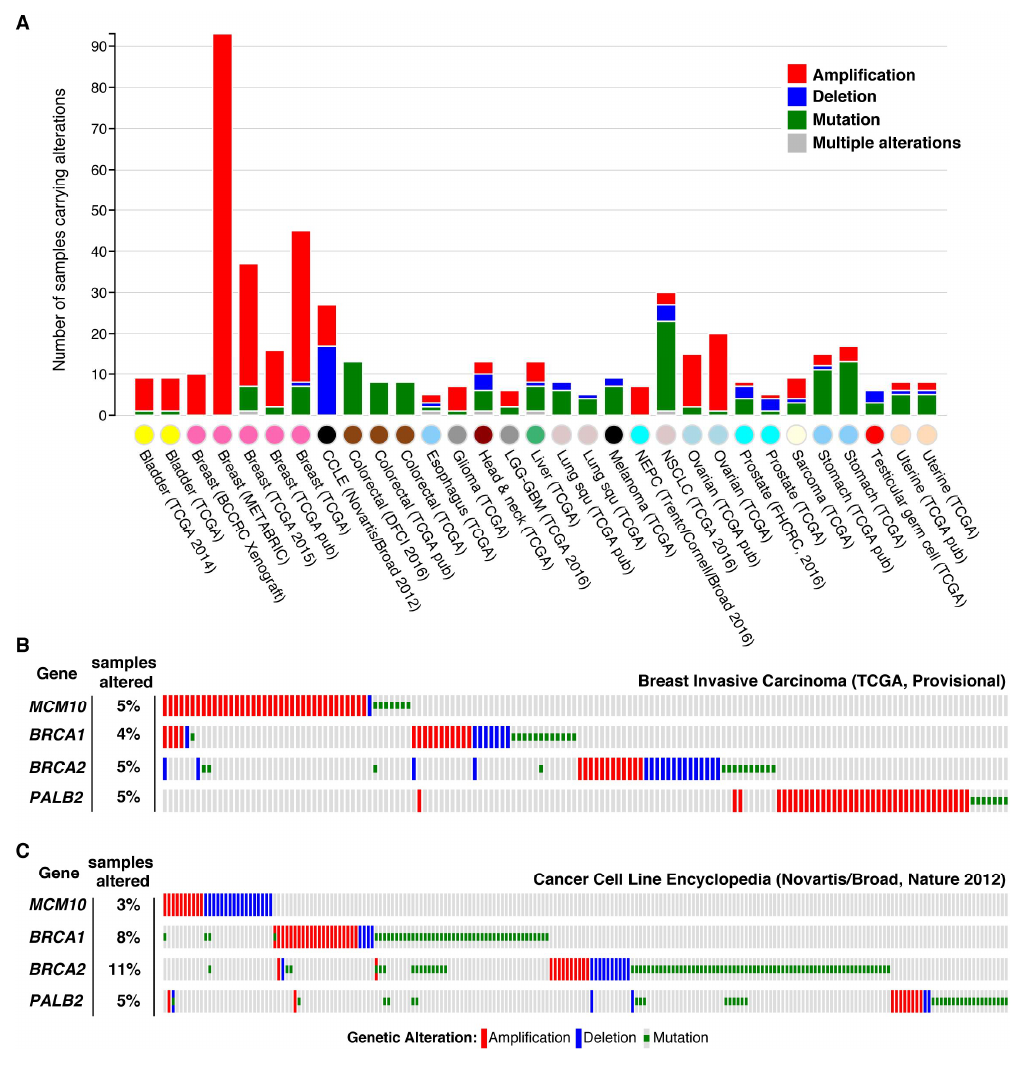
Figure 6. MCM10 alterations in human cancer samples and exclusivity with BRCA-associated mutations. ( A ) Bar graph showing the number and class of alterations including amplifications (red), deletions (blue), mutations (green) or a combination (gray) of MCM10 identified in different cancer types by multiple groups. The tissue/cell type and dataset for each column are listed on the x-axis. Only datasets with 5 or more MCM10 alterations are shown. ( B , C ) Plots showing the overlap of genetic alterations including amplifications (red), deletions (blue) and mutations (green) in MCM10 or breast cancer (BRCA) associated genes ( BRCA1, BRCA2, partner and localizer of BRCA2 (PALB2) ) in the Breast Invasive Carcinoma dataset (The Cancer Genome Atlas [TCGA]) ( B ) or the Cancer Cell Line Encyclopedia (Novartis/Broad) [171]. The data and depictions shown in this figure were accessed via and/or modified from information listed on the cBioPortal for Cancer Genomics (http://www.cbioportal.org/)